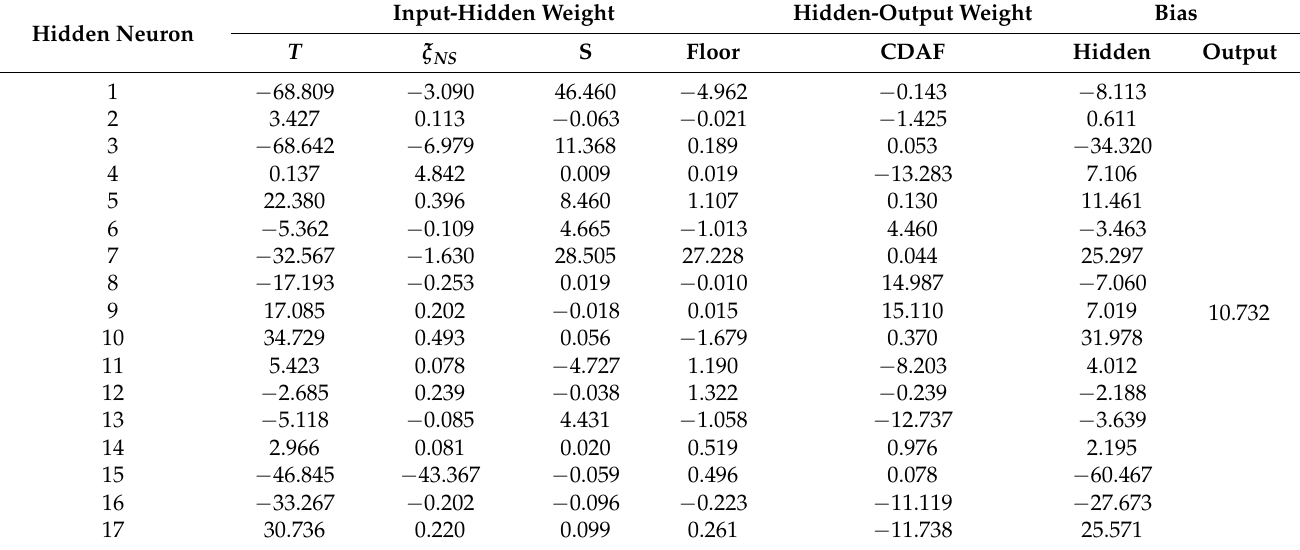
Table 7. Weights and biases of the ANN model for regular building.